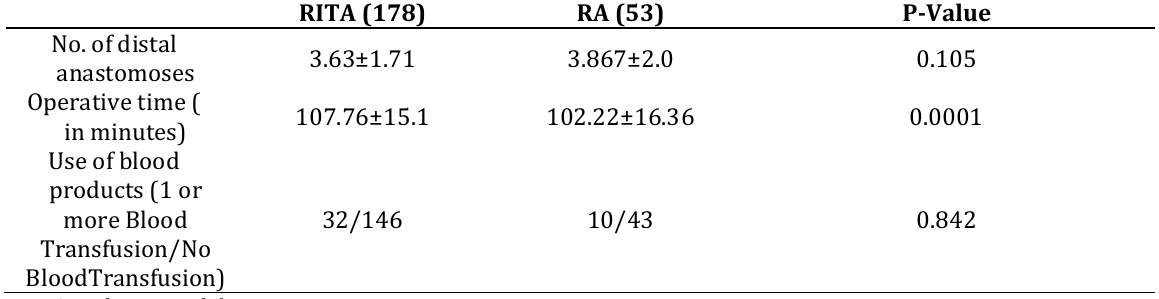
Table 2. Intraoperative variables between RITA and RA groups